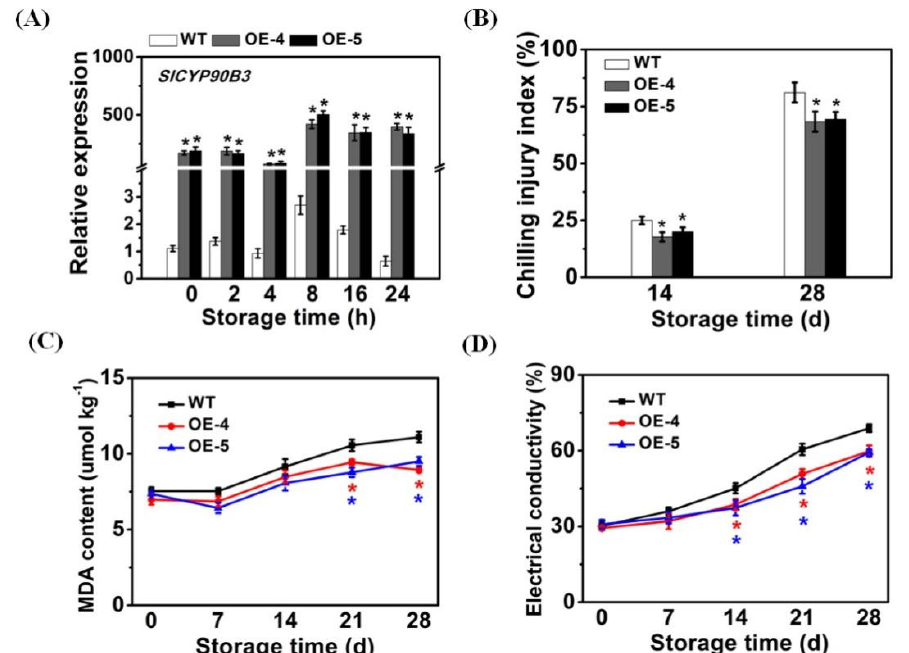
Figure 2. SlCYP90B3 overexpression alleviated tomato fruit chilling injury. ( A ) SlCYP90B3 expres- sion in SlCYP90B3 overexpression and wild-type tomato fruits. ( B ) Chilling injury index. ( C ) MDA content. ( D ) Electrical conductivity. Tomato fruits were stored for 28 days. Each data point is mean ± SE ( n =